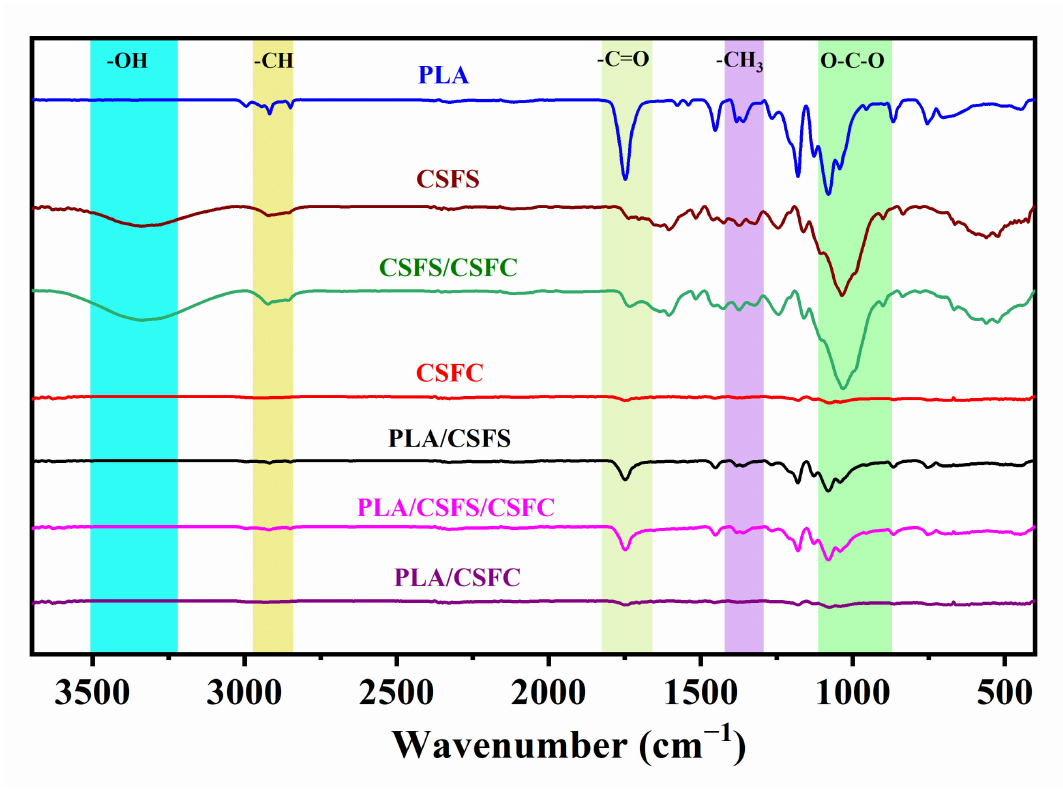
Figure 3. FT-IR spectra of PLA before and after mixing with CSF with different